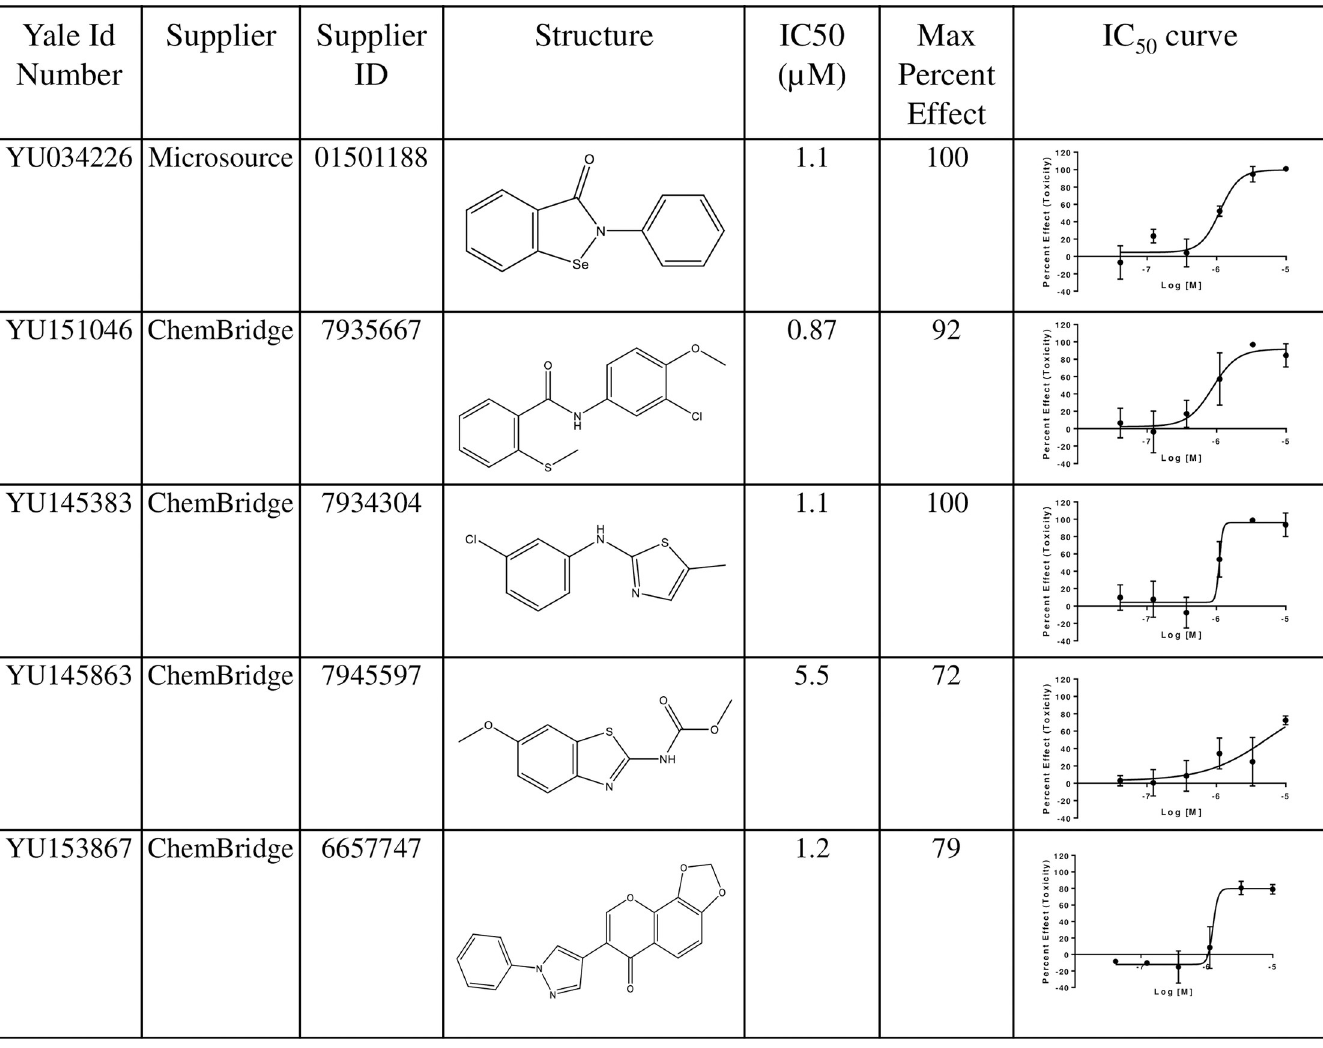
Fig 4. Schematic of the high throughput screening workflow.